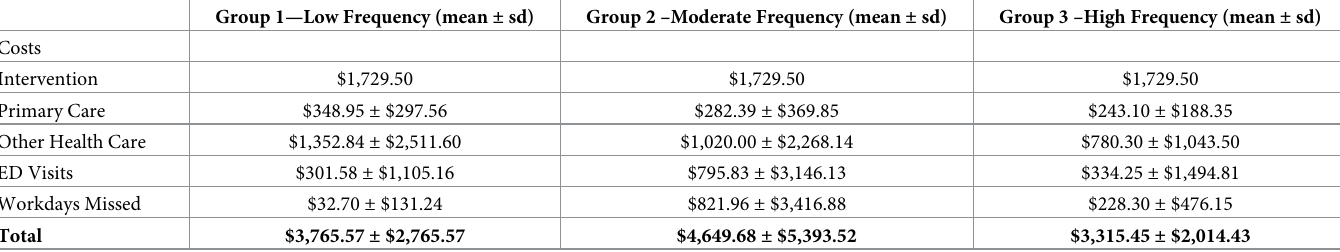
Table 3. Cost by incentive group.